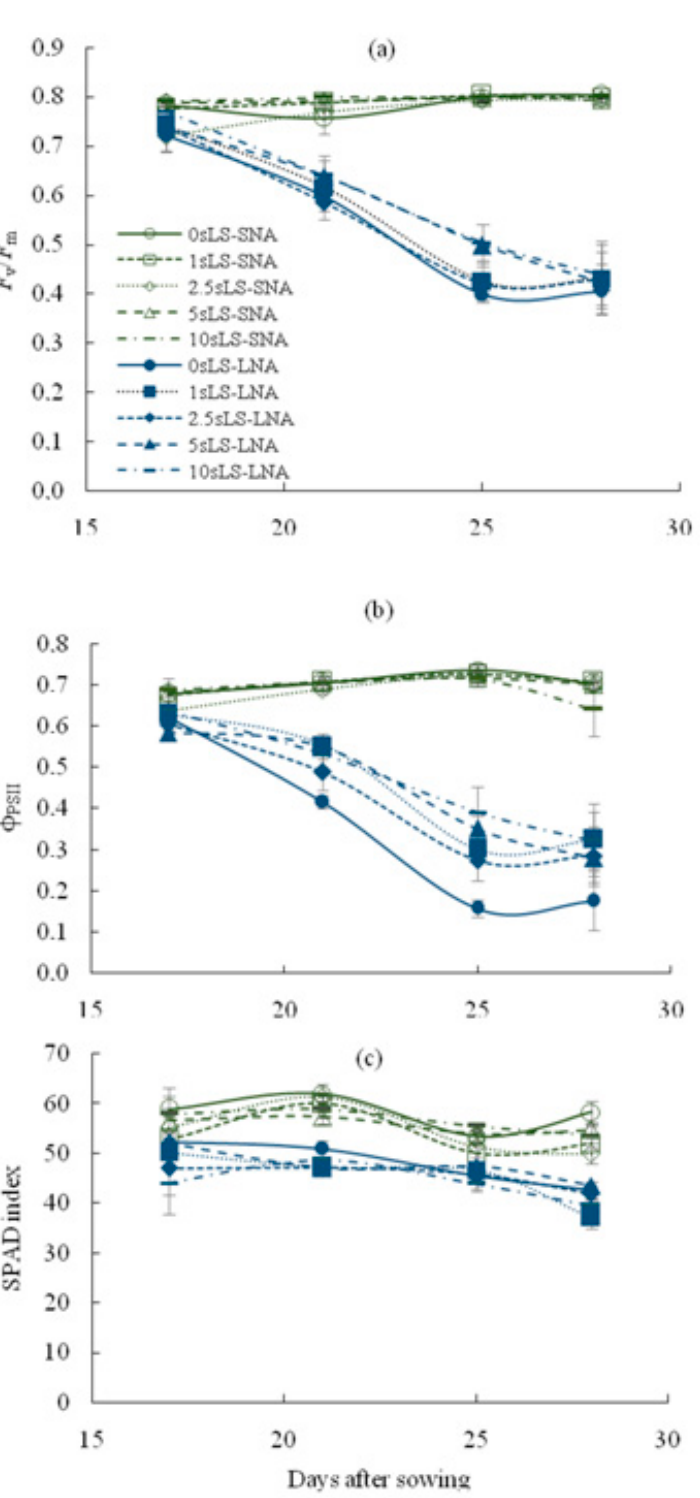
Figure 2. Temporal dynamics of the maximal quantum yield of PSII photochemistry (( a ), F v / F m ), actual quantum yield of PSII photochemistry (( b ), φ PSII ) and SPAD index ( c ) for cucumber seedlings grown on the sandy loam soil with a sodium lignosulfonate concentration of 0 (0sLS), 1 (1sLS), 2.5 (2.5sLS), 5 (5sLS), and 10 (10sLS) vol % under sufficient nutrient availability (SNA) or low nutrient availability (LNA).